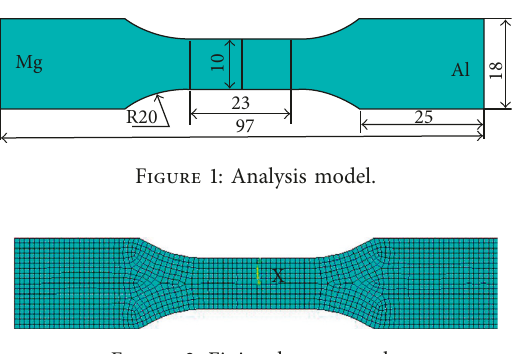
Figure 2: Finite element